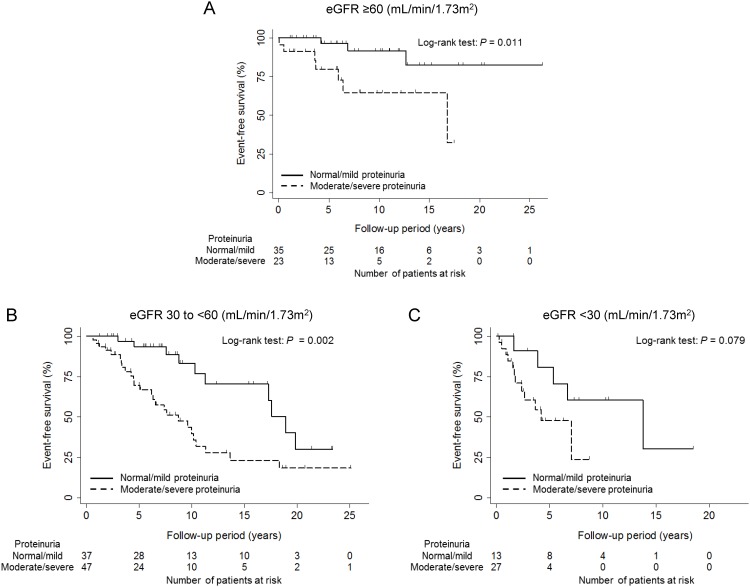
Event-free survival of renal events stratified by eGFR and proteinuria categories.A: eGFR ≥60 mL/min/1.73 m2. B: eGFR 30 to <60 mL/min/1.73 m2. C: eGFR <30 mL/min/1.73 m2. Abbreviation: eGFR, estimated glomerular filtration rate.